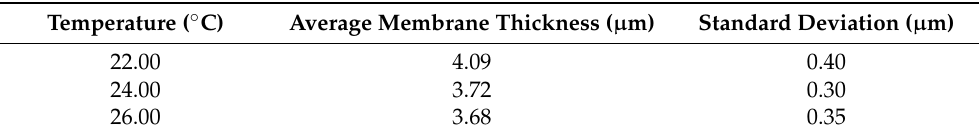
Figure 5. Membrane thickness as function of the environmental temperature. A one-way ANOVA test showed significant differences between the groups 1–2, 1–3; however, none between 2–3. (* p < 0.05 vs. Group 1, ** p < 0.01 vs. Group 1, r 2 = 0.83). Table 3. Measured thickness values of membranes produced in different room